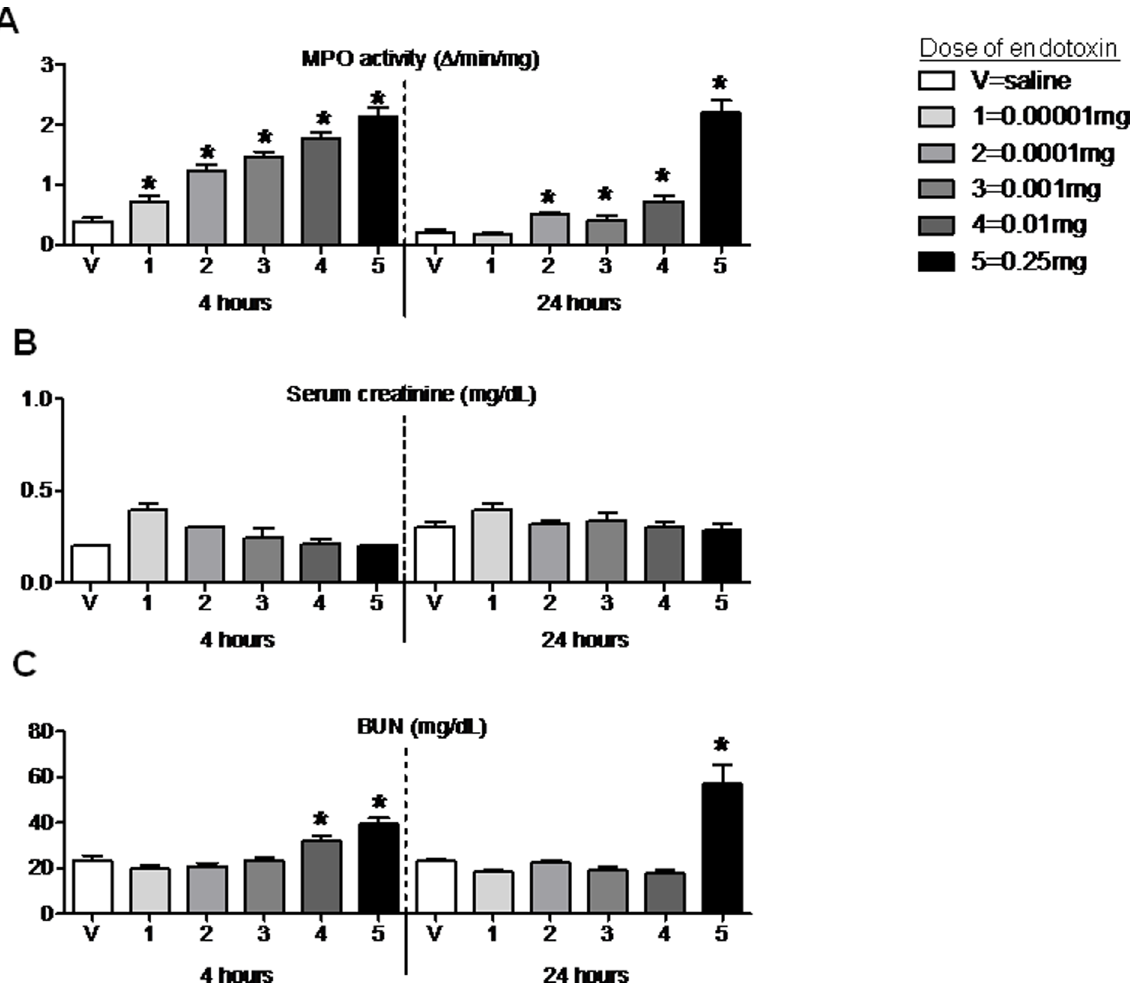
Figure 2. Lung MPO activity, serum creatinine, and BUN 4 hours after 5 different doses of intraperitoneal endotoxin. (A) Lung MPO activity, (B) serum creatinine, and (C) BUN were measured 4 and 24 hours (hr) after intraperitoneal saline injection (V, vehicle) or intraperitoneal injection of 5 different doses of endotoxin: 1 (0.00001 mg), 2 (0.0001 mg), 3 (0.001 mg), 4 (0.01 mg), and 5 (0.25 mg); n=4–14. *P , 0.05 versus V (saline) at the same time